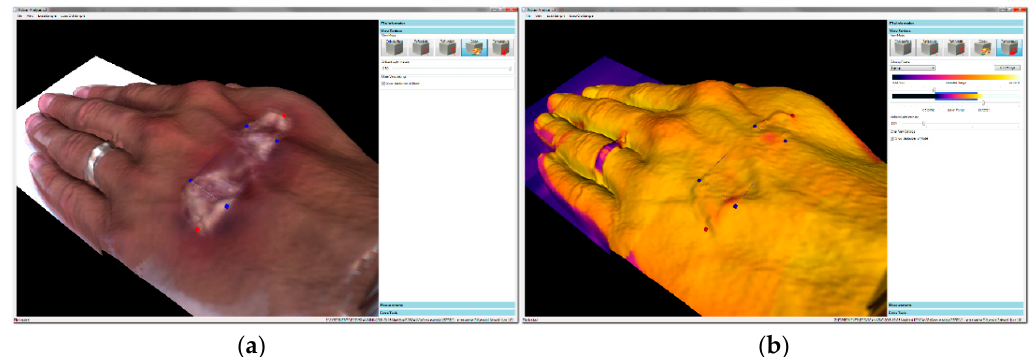
Figure 7. The navigation between several layers carried out by using points of interest (POIs): ( a ) selecting the area with suspicious features in the color layer; ( b ) examining the temperature at highlighted points in the thermal layer. In this case, we did not observe any thermal changes relating to the effect indicated in the image ( a ); the observation corresponds to reality, as the injury was created by a make-up artist.